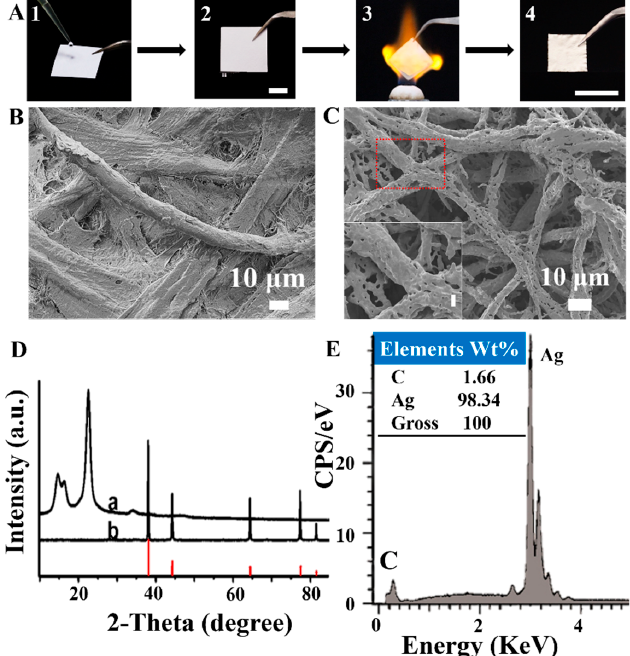
Figure 1. Fabrication of the paper-templated silver. ( A ) Digital photographs showing the fabrication process of silver from paper template (scale bar: 1 cm). SEM images of ( B ) the paper template and ( C ) the silver fabricated from the paper template. Inset: enlarged SEM image of the red square with a scale bar of 10 μ m. ( D ) XRD patterns of (a) the paper and (b) the paper-templated silver. The red lines inserted are a PDF card of silver (PDF#04-0783). ( E ) Energy dispersive spectroscopy (EDS) spectrum of the paper-templated silver. CPS: counts per second.